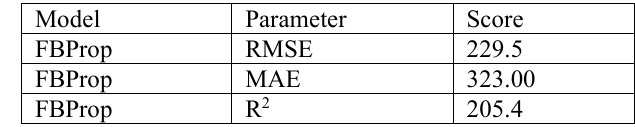
Table 4. Performance Analysis of FBProp